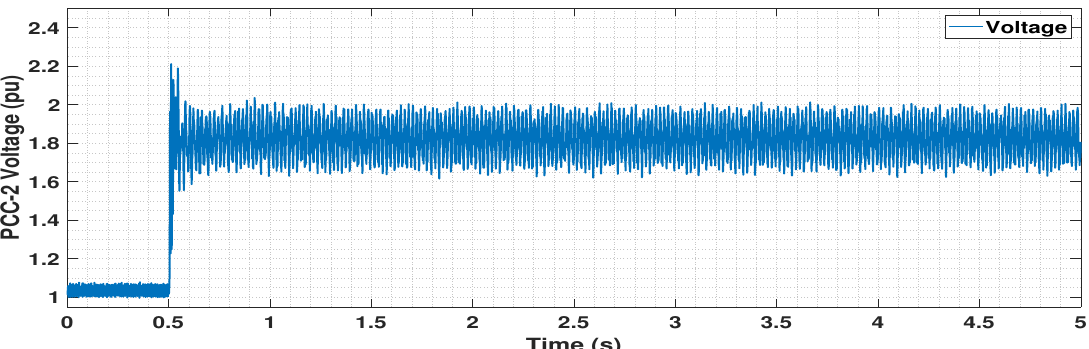
Figure 27. Voltage in p.u. at PCC-2 upon OWF-2 disconnection event.